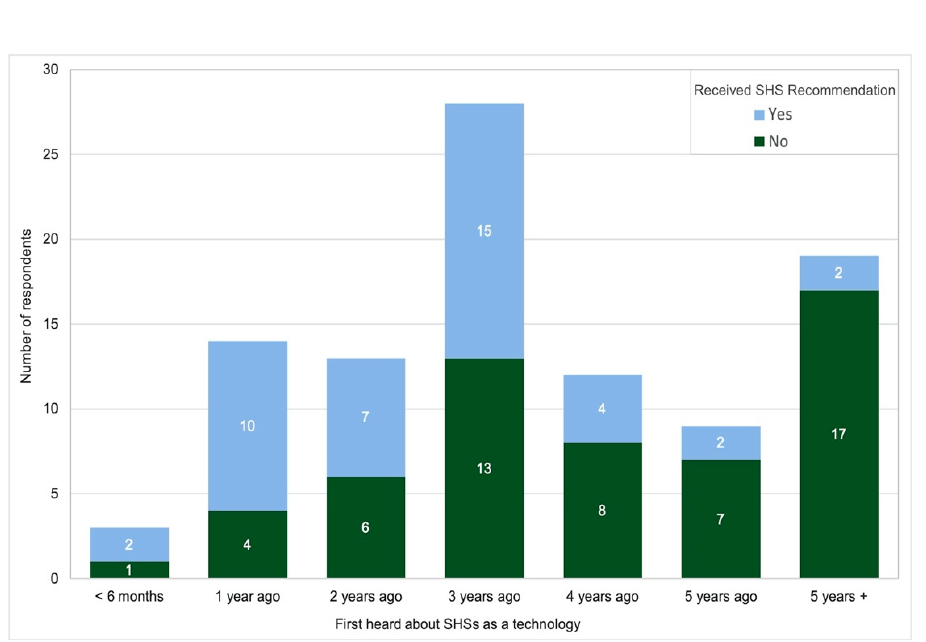
Figure 3. Respondents who first heard about SHSs, split by receiving a SHS